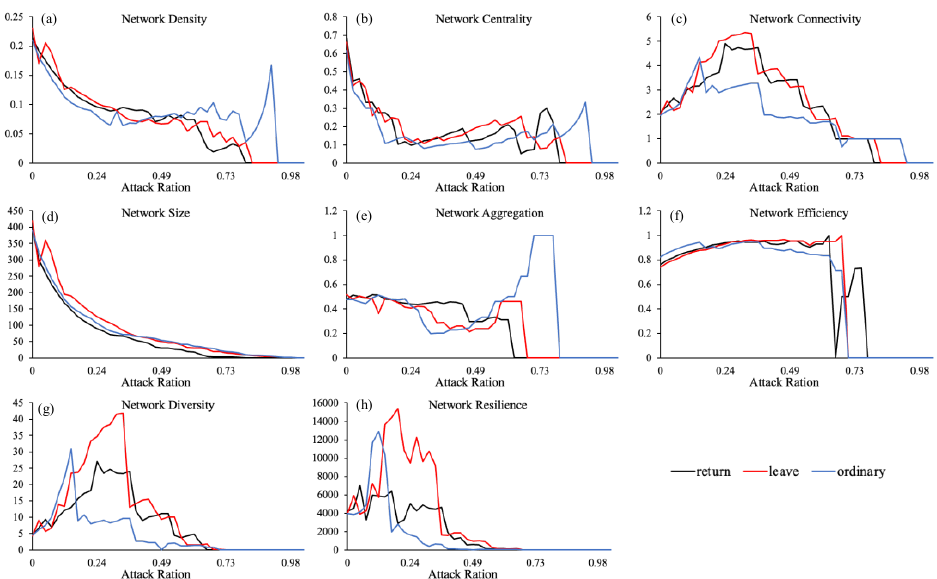
Figure 6. Changes in complex network topological indexes under different disruption scenarios.